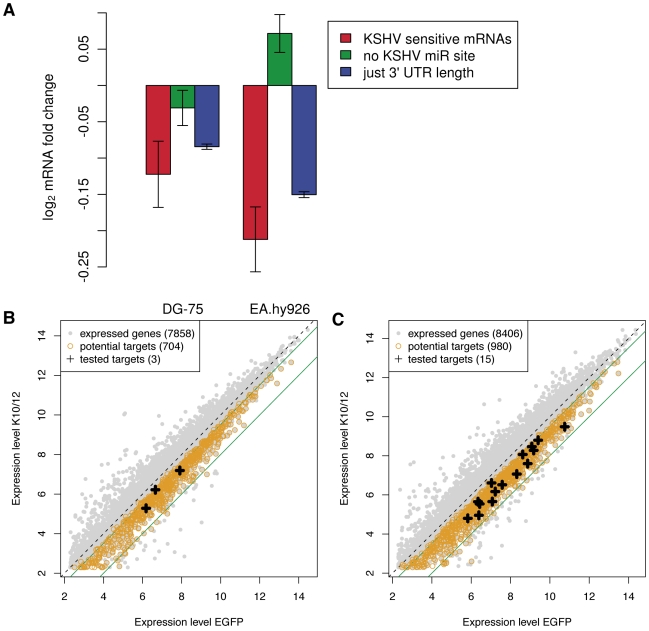
Microarray analysis of KSHV miRNAs expressing cell lines.
A. Changes in expression levels of KSHV miRNA sensitive mRNAs, mRNAs without KSHV miRNA seed matches in their 3′ UTR, and randomized sets of genes with the same 3′ UTR length distribution as KSHV miRNA sensitive mRNAs. The analysis was performed separately in DG-75 and EA.hy926 cells. Error bars represent 95% confidence interval on the mean fold change in gene expression upon transducing the KSHV miRNAs. Dot plot representation of the changes in gene expression observed in the DG-75 cells (B), and in the Ea.hy926 cells (C). The potential targets (black crosses) tested by luciferase assay were selected among the genes down-regulated 1.4 to 4 fold (indicated by the green lines).